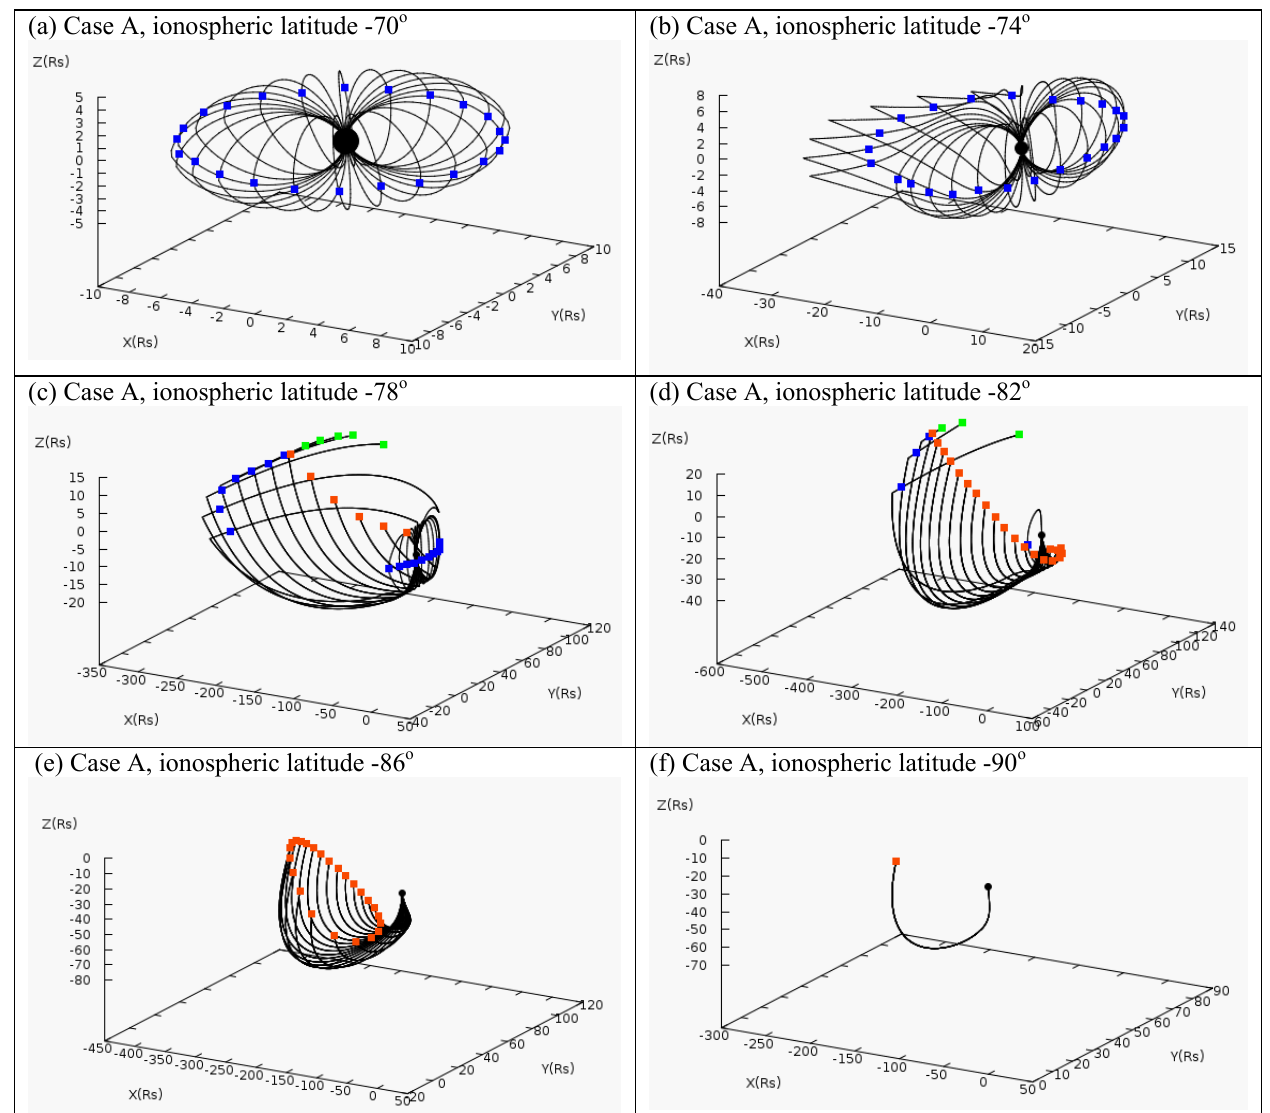
Fig. 7. Plots showing model magnetic field lines whose ionospheric footprints lie at constant southern latitudes, for the field model cor- responding to case A with IMF penetration coefficient k s = 0 . 2. The format is similar to Fig. 3. Blue squares mark intersections of the field lines with the planet’s equatorial plane, while red and green squares mark intersections with the southern and northern magnetopause,